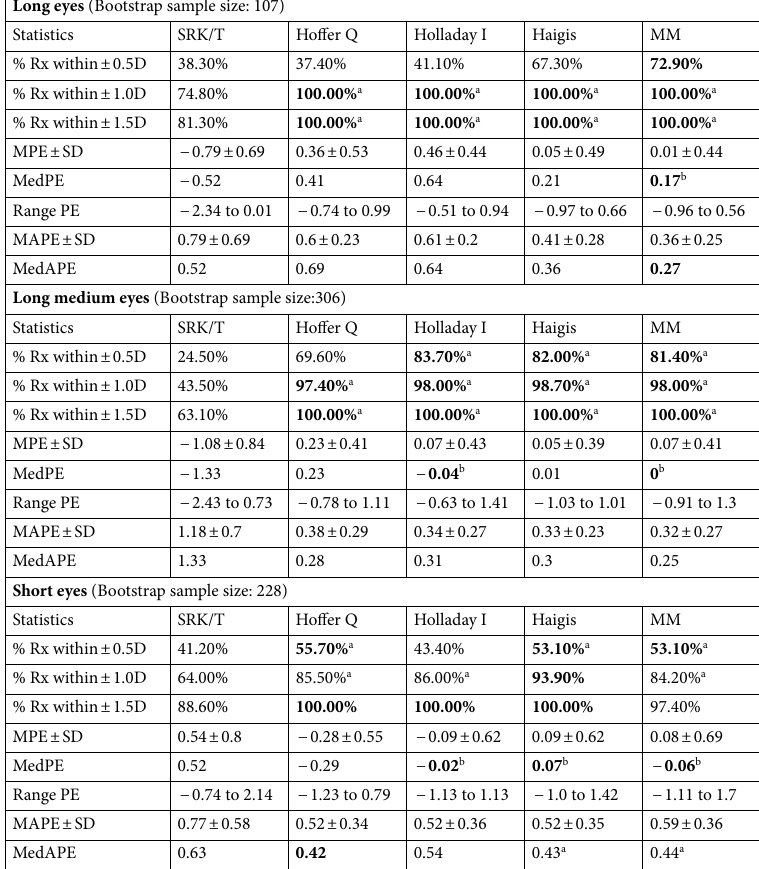
Table 5. Summary statistics of the cross-validation results for each of the five formulae (SRK/T, Hoffer Q, Holladay I, Haigis and MM) for long, long medium and short eyes. % Rx Percentage of eyes within a given range of prediction error, MPE Mean prediction error, MedPE Median prediction error, Range PE Range of the prediction error, MAPE Mean absolute prediction error, MedAPE Median absolute prediction error, SD Standard Deviation of the error. a No statistically significant difference at level 0.05. b No statistically significant difference from zero at level 0.05. Significant values are in